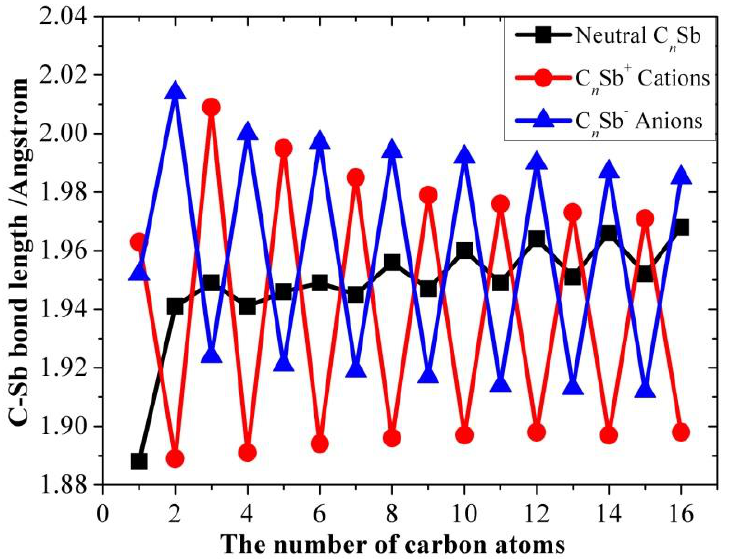
Figure 5. C-C bond length alteration of C n Sb − anions ( n = 11 – 16) as a function of number of carbon atoms.